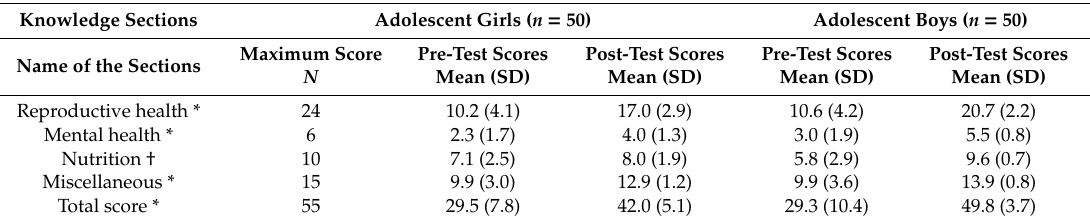
Table 3. Construct validity scores at pre- and post-intervention stage among adolescent girls and boys ( n = 100).